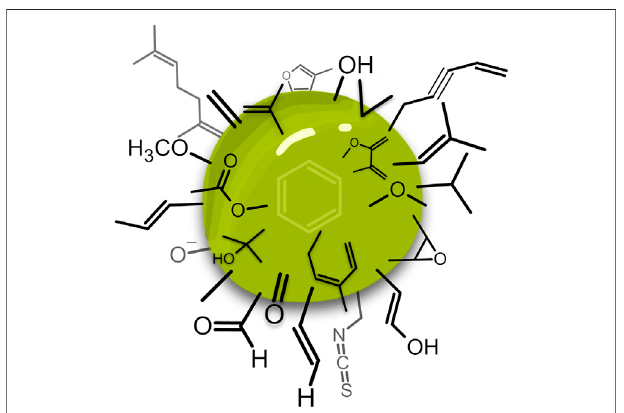
FIGURE1| ConceptofEOsactingasMOCSwithmulti-targetfunctional groups.